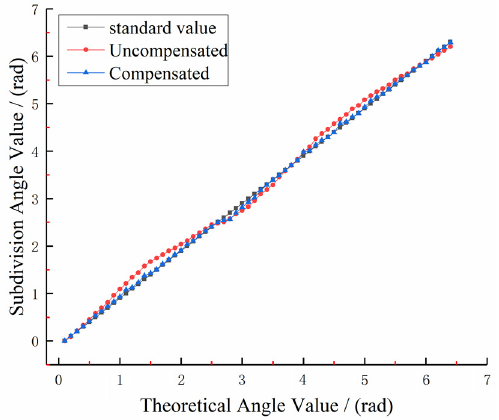
Figure 17. Subdivision error of the signal before and after error compensation.